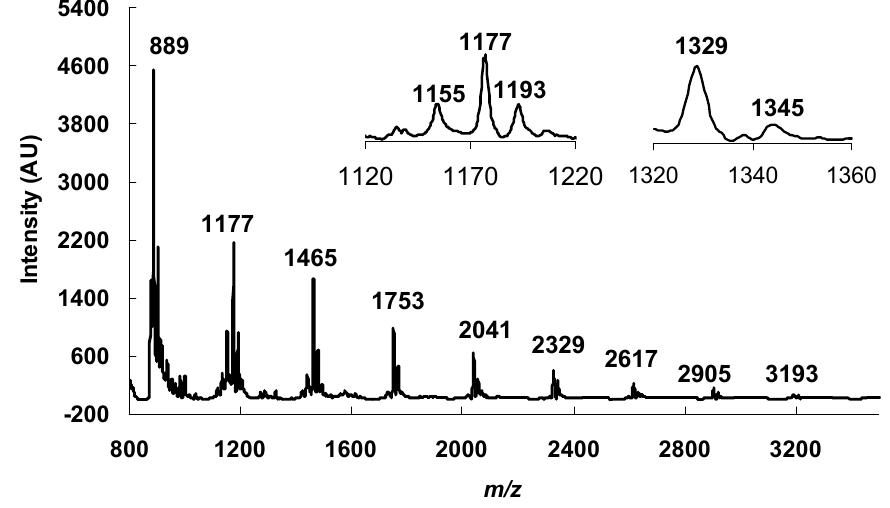
Figure 5. MALDI-TOF mass spectrum in positive linear mode, showing a procyanidin series [M+Na] + from the trimer ( m/z 889) to the nonamer ( m/z 3,193). Inset is an enlarged spectrum of masses representing a procyanidin series with the presence of protonated trimer at m/z 1,155 and hydroxylated trimer at m/z 1,193. Small amount of gallated trimer were also detected at m/z 1,329 (=1177 + 152 (gallate)), and its hydroxylated compound at m/z